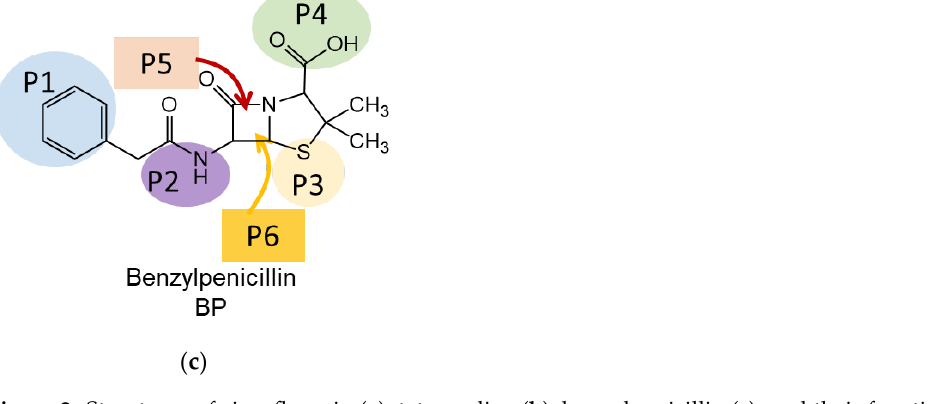
Figure 2. Structures of ciprofloxacin ( a ), tetracycline ( b ), benzylpenicillin ( c ), and their functional groups considered in the theoretical calculations.